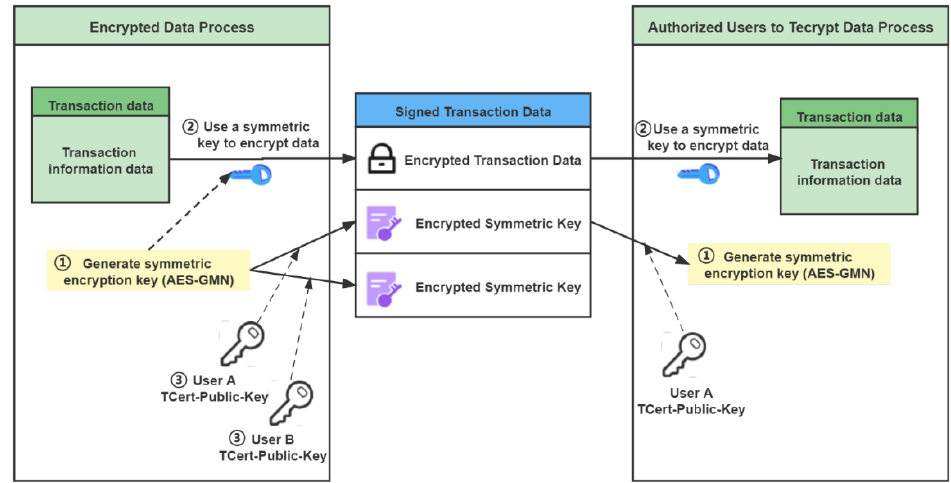
Figure 10. Data information encryption and decryption